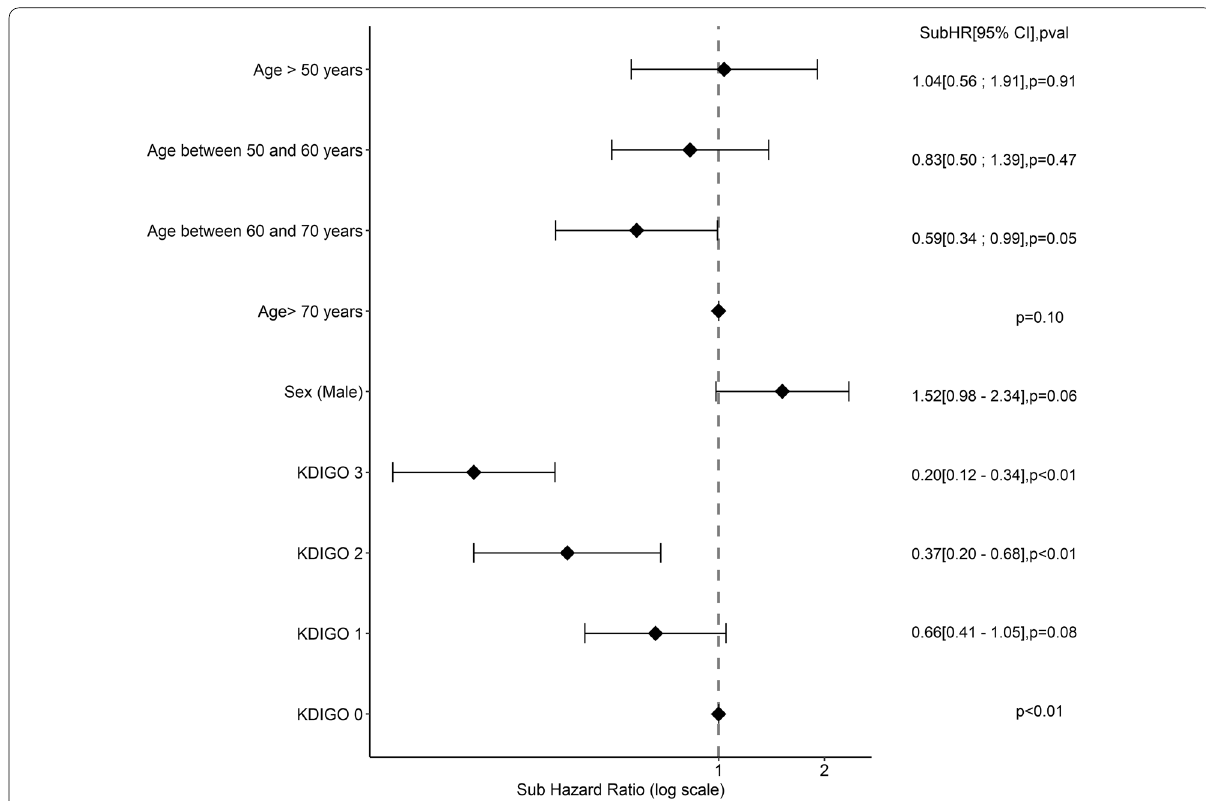
Fig. 3 Factors associated with late ARC—multivariate analyses. OR odds ratio, CI 95% confidence interval, HR hazard ratio. Factors tested in multivariate analysis for the risk of late ARC were age, sex (male), BMI > 30 kg/m 2 , SARS COV 2 pneumoniae, immunosuppression, catecholamines, KDIGO (Kidney Disease: Improving Global Outcome score), parenteral nutrition, aminoglycosides, vancomycins, proton‑pump